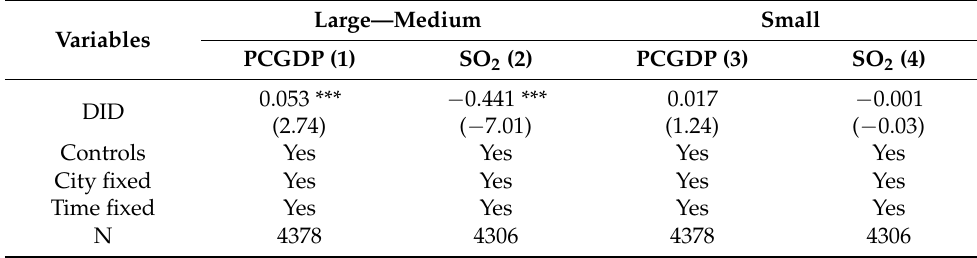
Table 6. The heterogeneity test at the city scale